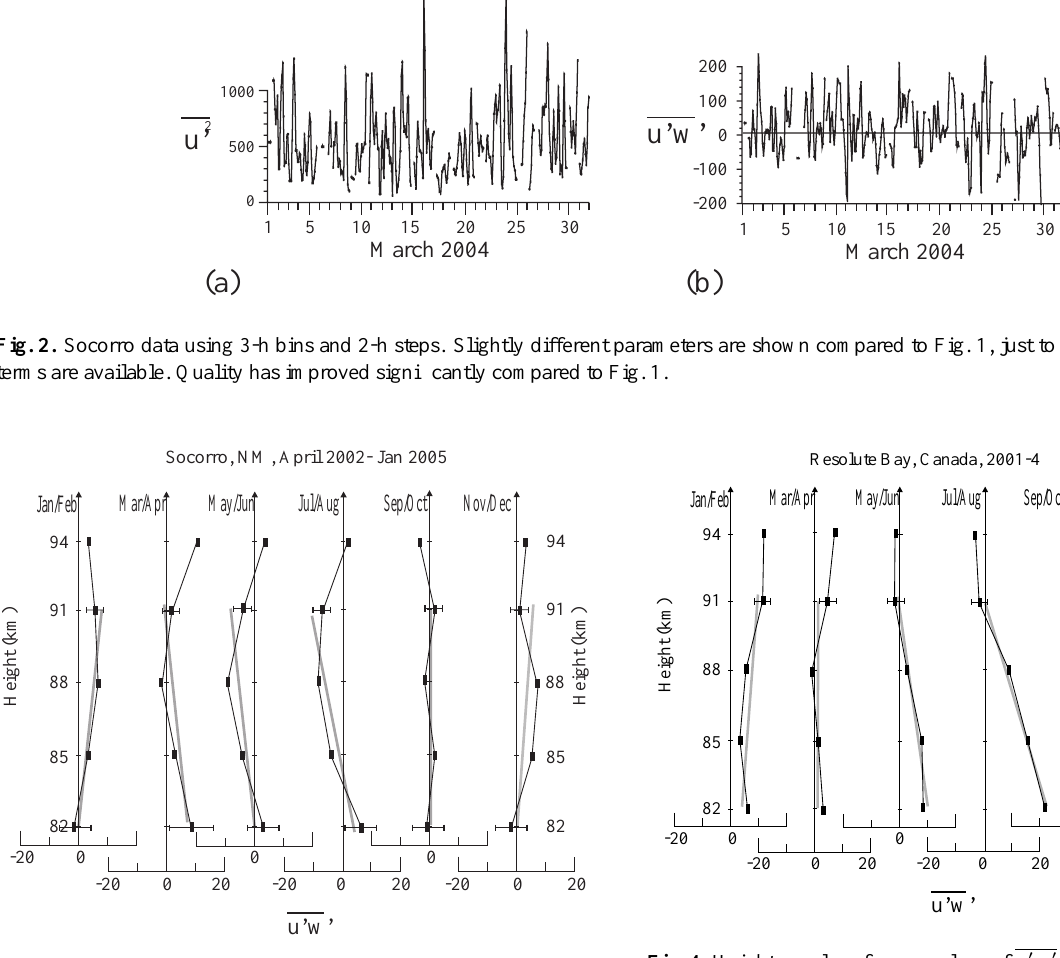
Fig. 3. Height profiles of mean values of u 0 w 0 for Soccorro, for the period April 2002 to January 2005, plotted as two-monthly aver- ages.